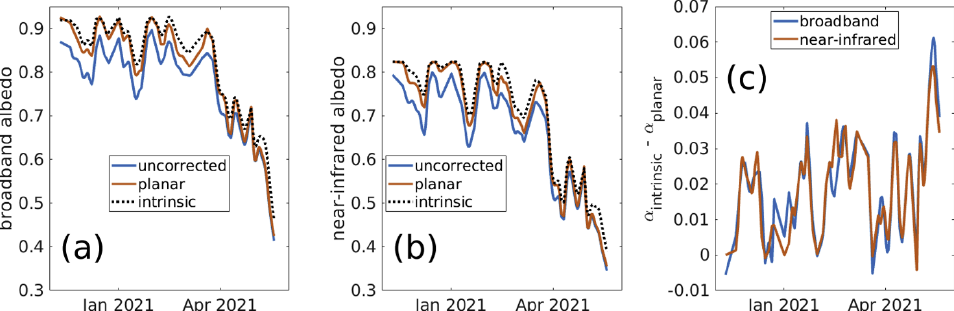
Figure 6. In situ albedos on Mammoth Mountain in the water year 2021. Shown are the uncorrected, planar-corrected, and intrinsic albedos for broadband (a) and near-infrared (b) wavelengths. Planar correction involved fitting a plane to the snow surface and using the solar illumi- nation angle on that plane compared to that on a flat surface. Intrinsic albedos are derived from analyzing the view factors and illumination angles on the rough surface and using Eqs. (4) through (9) to solve for α intrinsic . The difference between the intrinsic and planar albedos is shown in (c)